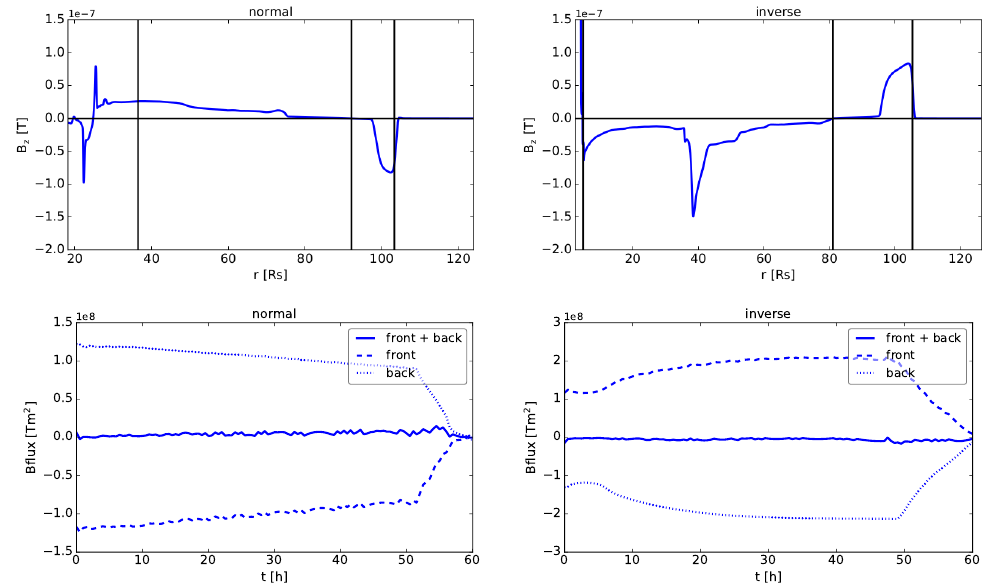
Figure 10. Upper panels: B z along the equatorial plane for a normal ( left ) and an inverse ( right ) CME ejected in a middle density wind with a medium initial velocity 25 h after initiation. The first and last vertical line represent the front and rear edge of the separatrix while the central vertical line represents the centre of the magnetic cloud. Bottom panels show the total magnetic flux in the front part (dashed), rear part (dotted), and the sum of both (solid).